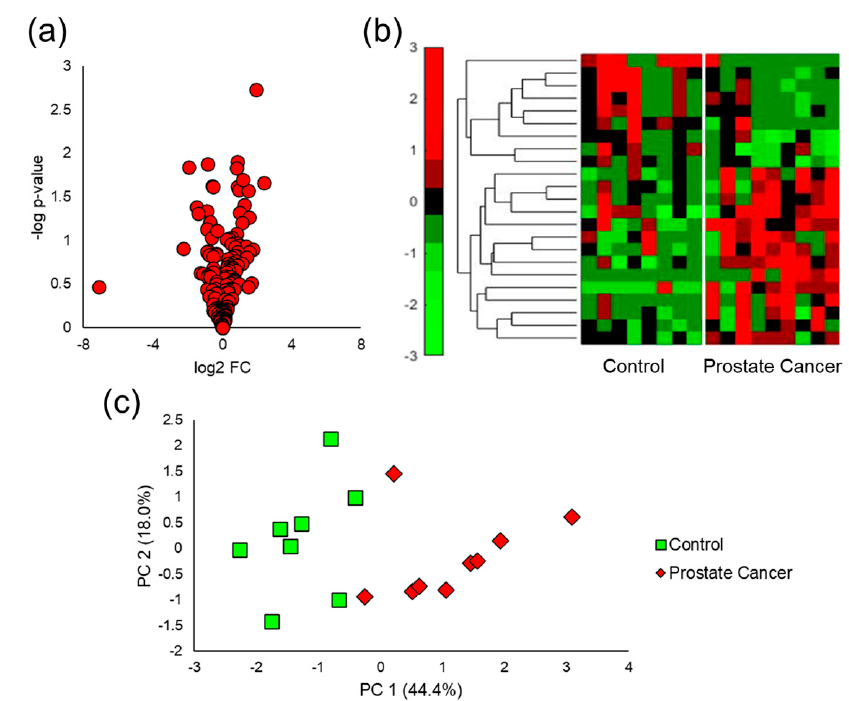
Figure 2. Univariate and multivariate chemometric analysis of mouse urine for prostate cancer VOC biomarker identification. ( a ) Volcano plot interpolating statistical significance as a function of log 2 fold change shows more VOCs were upregulated by prostate cancer, ( b ) hierarchical heatmap of the VOCs differentially expressed shows that VOCs have higher interclass variation, and ( c ) PCA of the top five VOCs completely distinguishes healthy controls from tumor-bearing mice with 100% accu- racy.